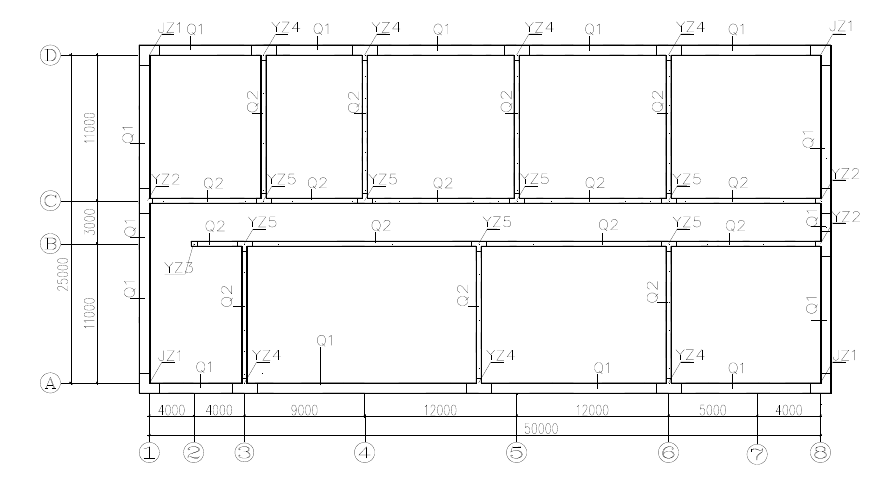
Figure 2. Dimensions of the floor and wall.